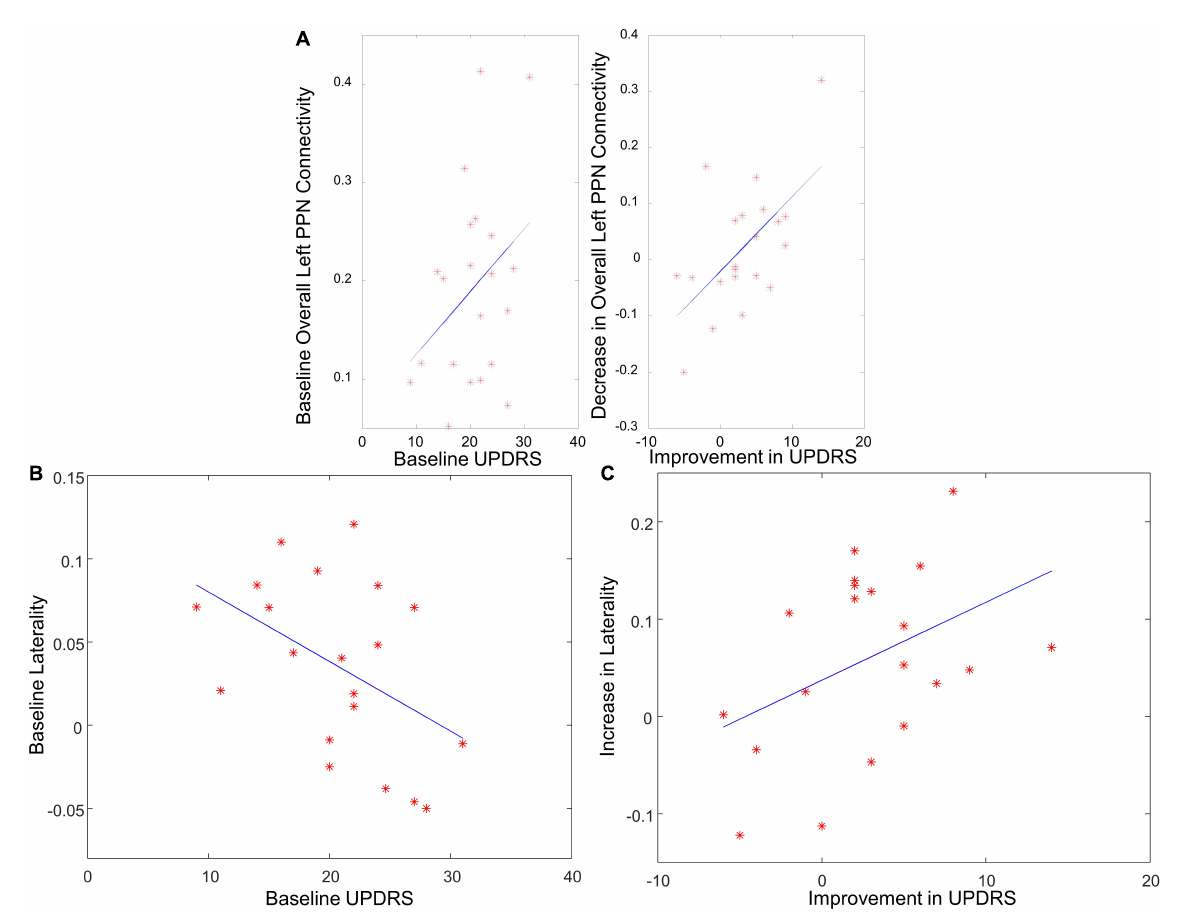
FIGURE6 The correlation between PPN functional connectivity and UPDRS score. (A) The correlation between overall left PPN functional connectivity and UPDRS score at baseline, and between the decrease in overall left PPN functional connectivity and UPDRS improvement. (B) The correlation between the laterality of PPN connectivity strength and UPDRS score at baseline. (C) The correlation between the increase in laterality of PPN connectivity strength and UPDRS improvement.